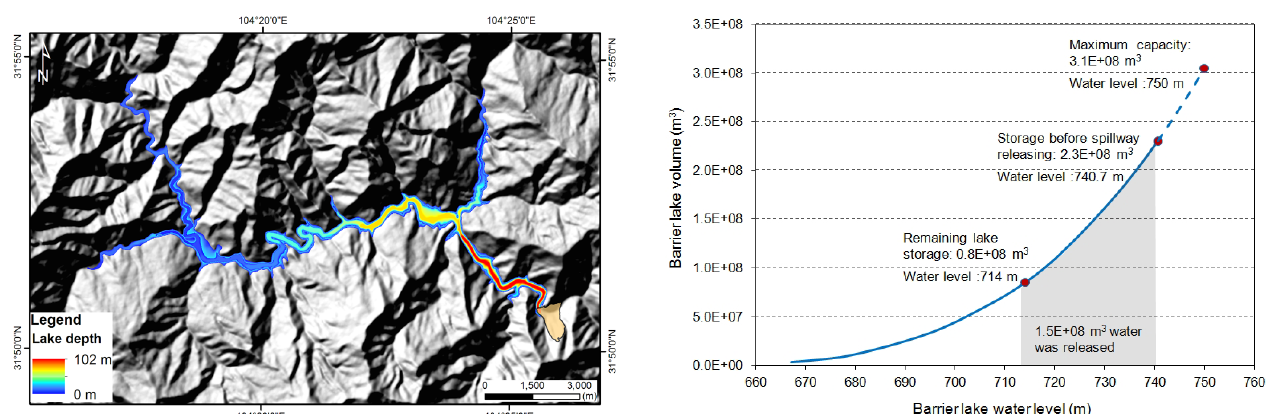
Fig. 7. Variation of the barrier lake depth (the background is the shaded relief map of the pre-earthquake 25-m DEM).